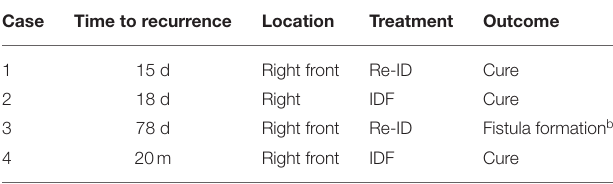
TABLE 3 | Characteristics and course of recurrent patients after initial surgery a . Case